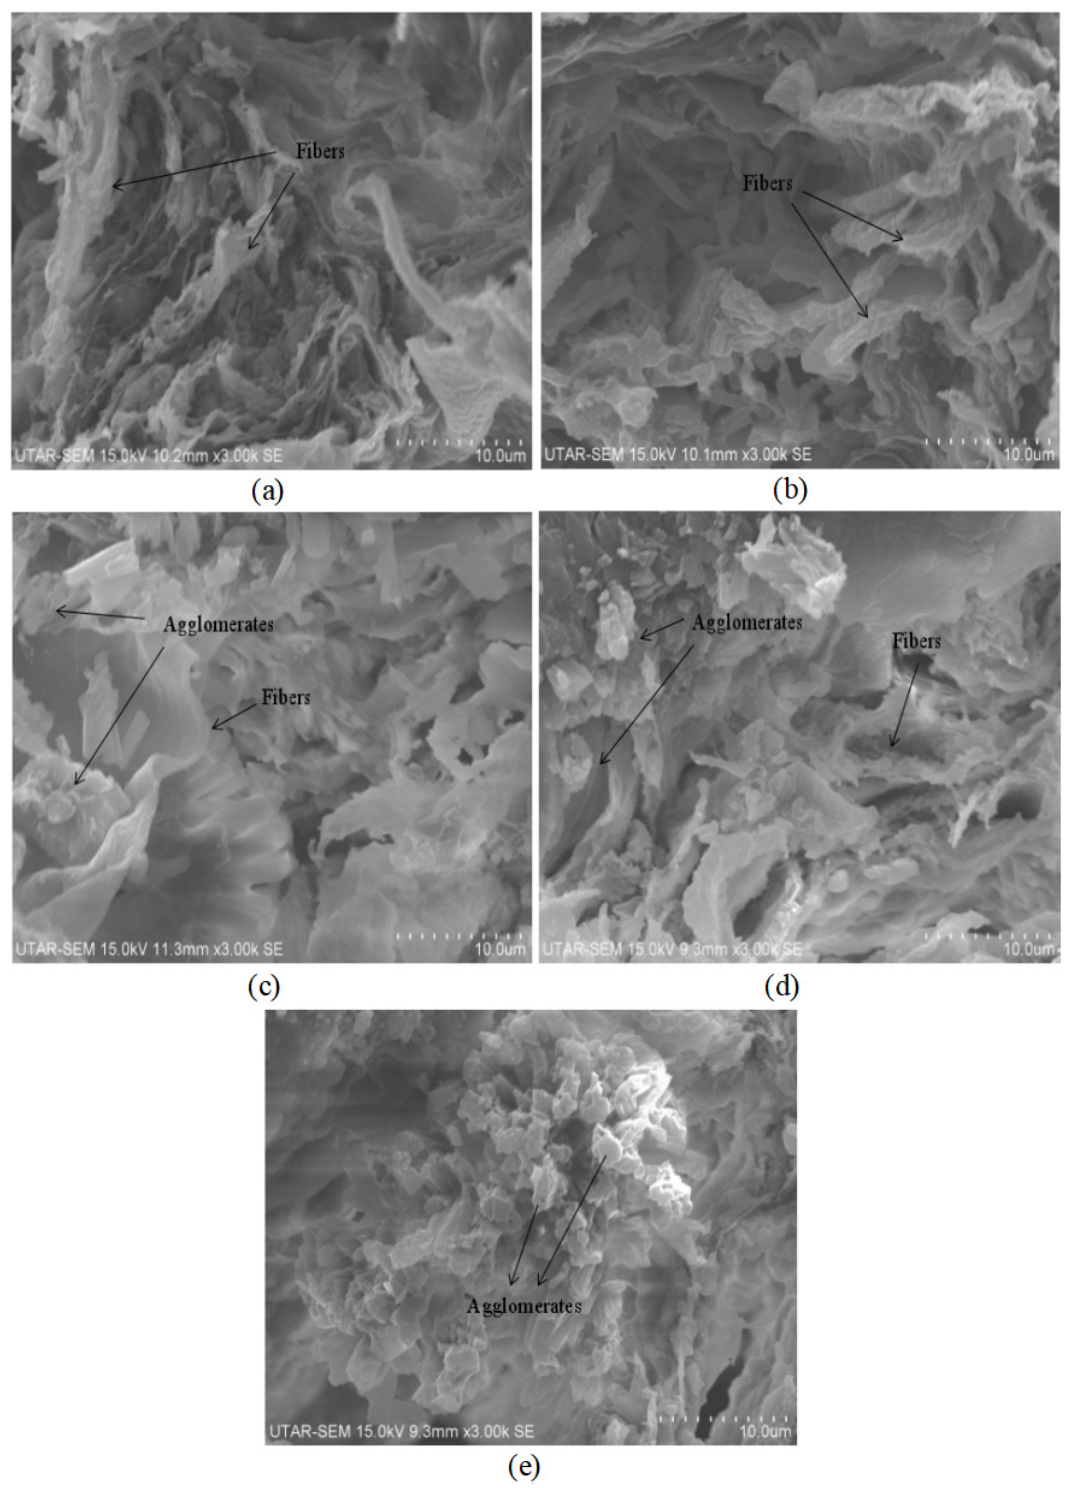
Figure 15. SEM Image of Graphite Nanosheets Treated at 200 °C and − 0.1 MPa/Nylon 610 Nanocomposite at ( a ) 0.5 wt%, ( b ) 1.5 wt%, ( c ) 2.5 wt%, ( d ) 3.5 wt%, ( e ) 4.5wt% at ×3000 magnification.